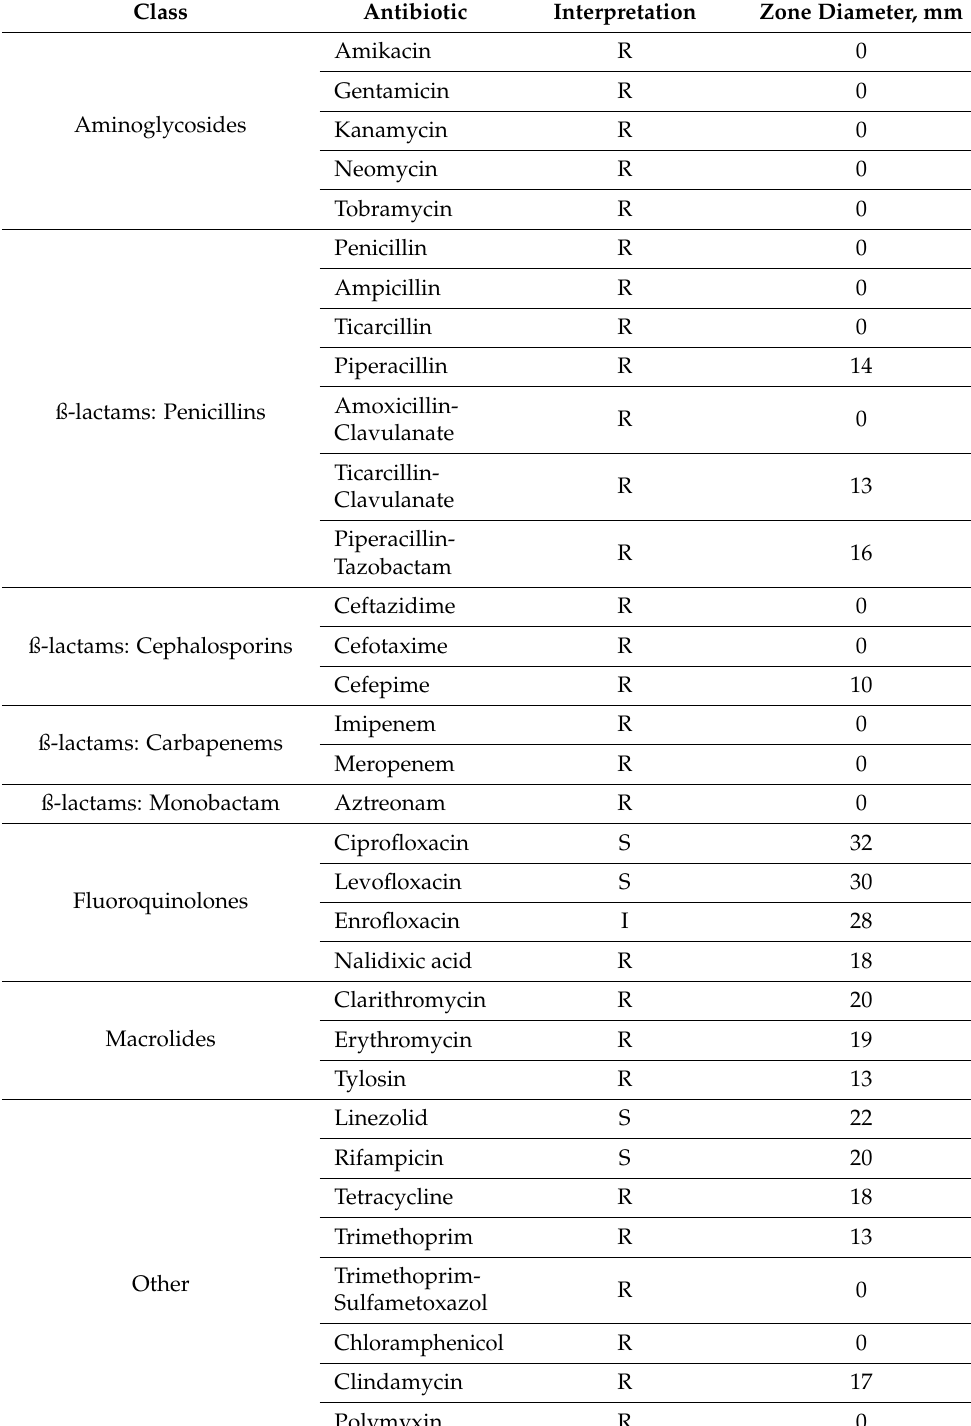
Table 1. List of antibiotics tested and values of inhibition zones